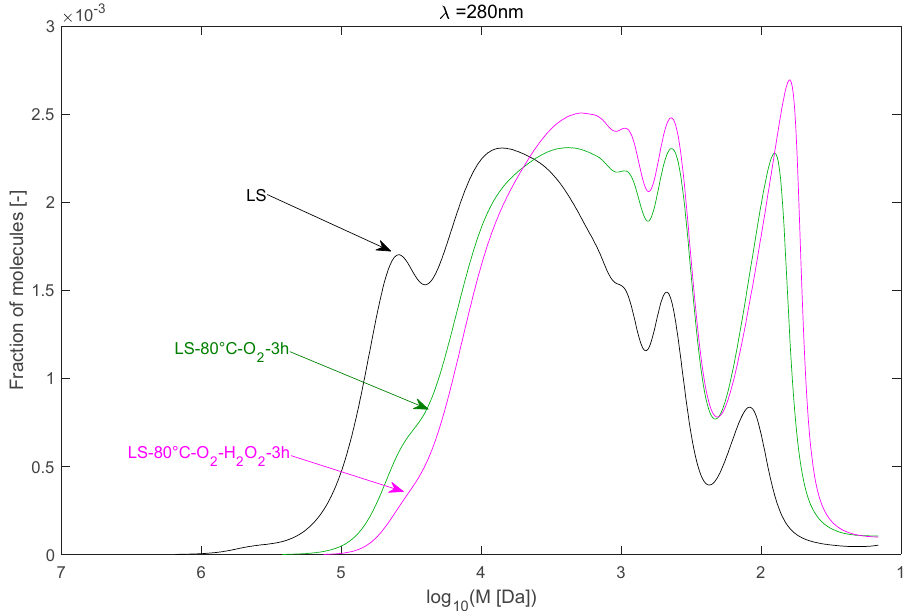
Figure 7. Effect of H 2 O 2 addition on the molecular weight distribution of LS during the depolymerisation.